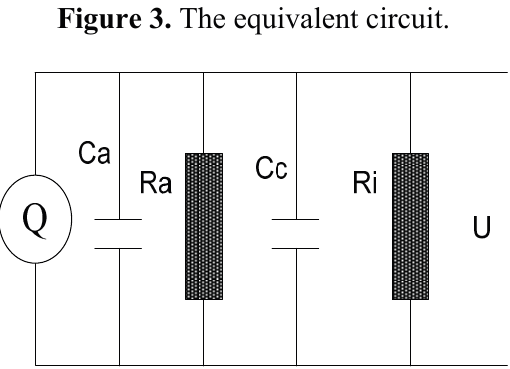
Figure 3. The equivalent